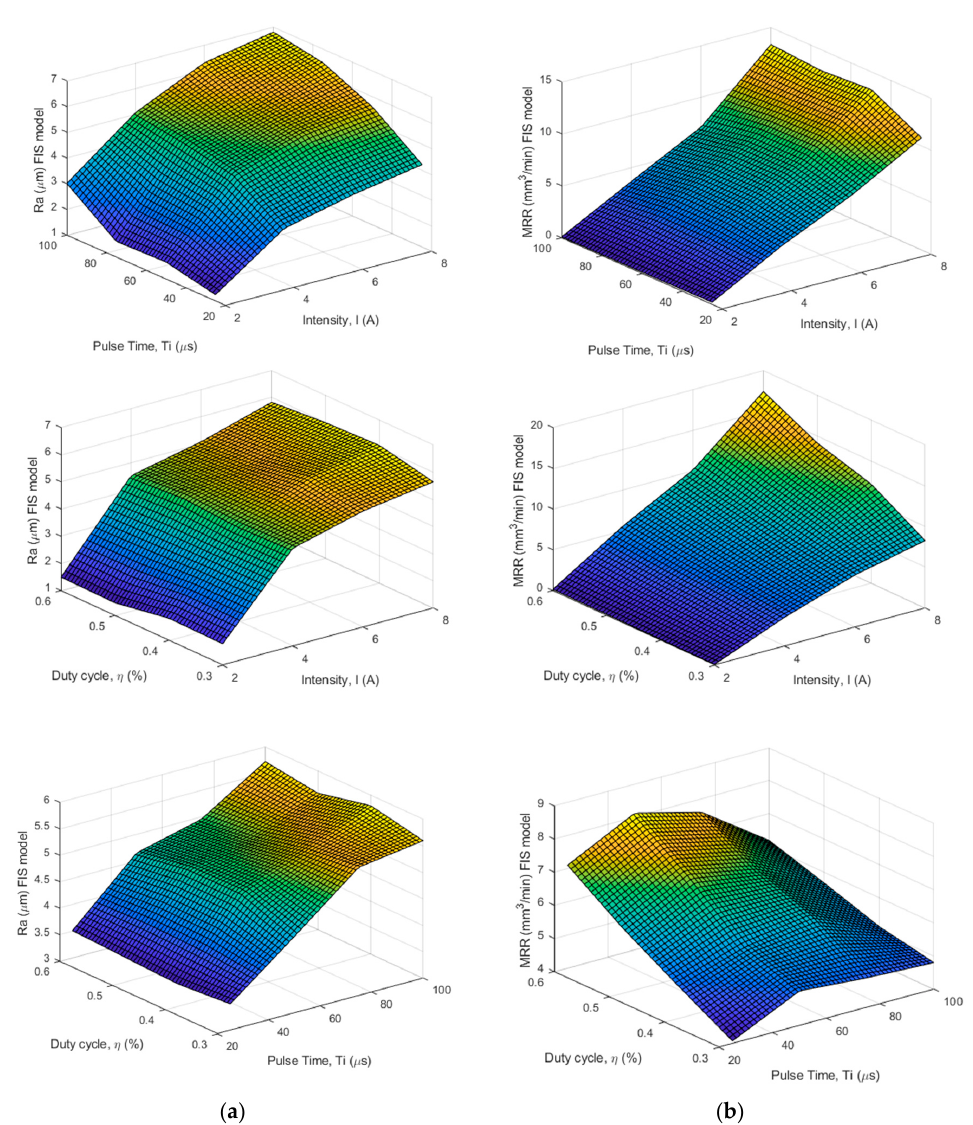
Figure 9. Response surfaces obtained with the FIS for the case of positive polarity: ( a ) Ra; ( b ) MRR.